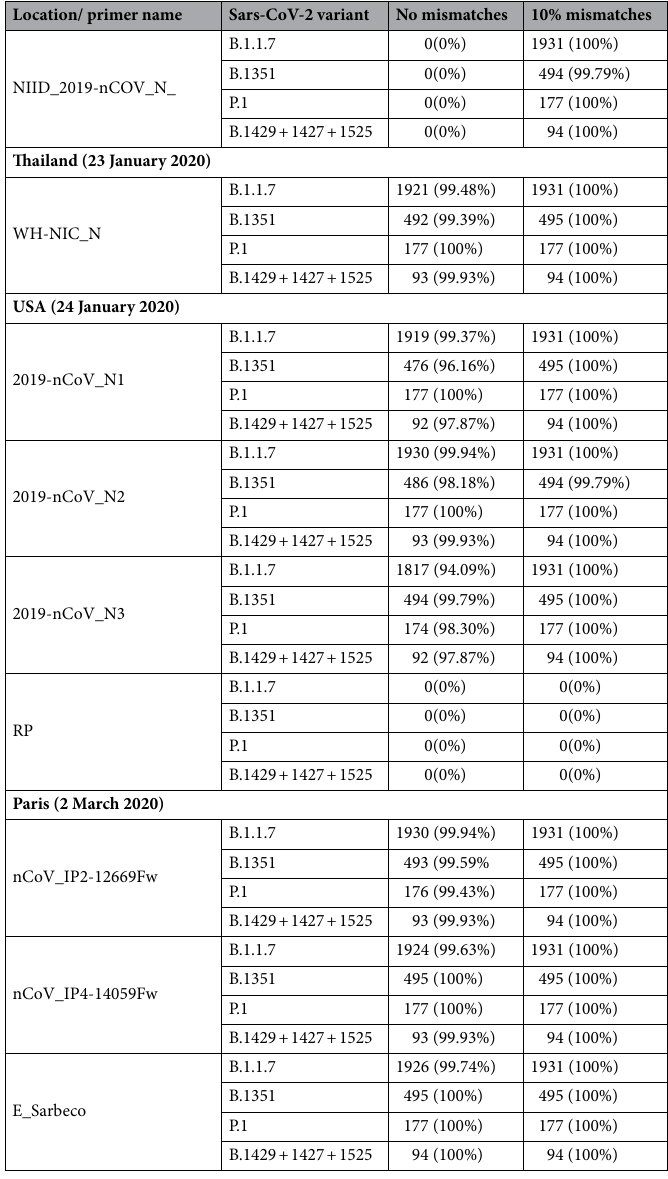
Table 4. Analysis of potential annealing (In silico PCR) of WHO primers (PD_primers) to the genomes of the main SARS-CoV-2 variants. The percentage of the total number of sequences that annel without mismatches or allowing 10% mismatches are shown in parentheses. No mis number of sequences that anneal to the primer without mismatches; 10% mis number of sequences that anneal to the primer allowing 10%